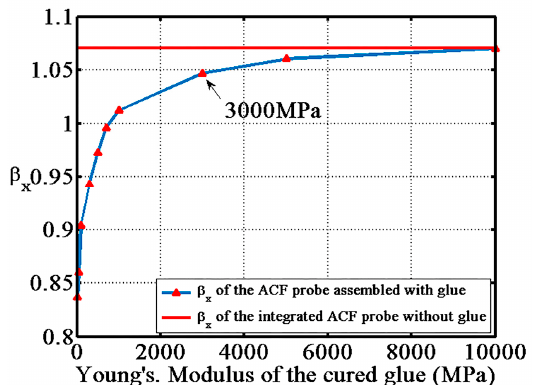
Figure 6. The relationship between the Young’s modulus of the cured glue.